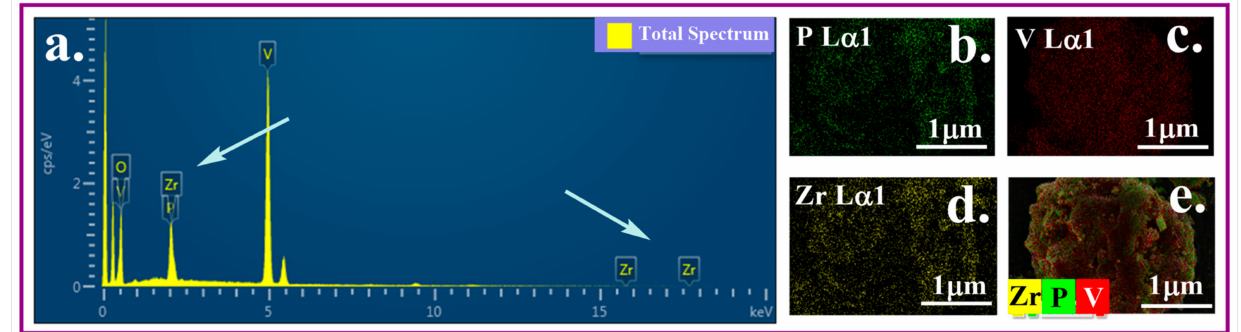
Figure 11. The total EDS spectrum of the monometallic Zr-DES precursor reveals the spectrum peaks of V, P, O and Zr ( a ). EDS maps illustrate the distribution of phosphorus ( b ), vanadium ( c ), zirconium ( d ), and all elements ( e ).